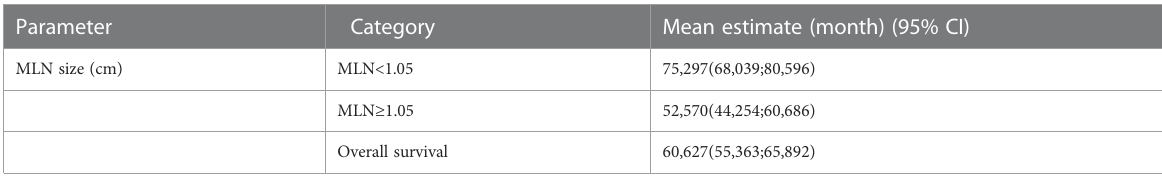
TABLE 4 Kaplan-Meier analysis of the relationship between MLN size and survival.